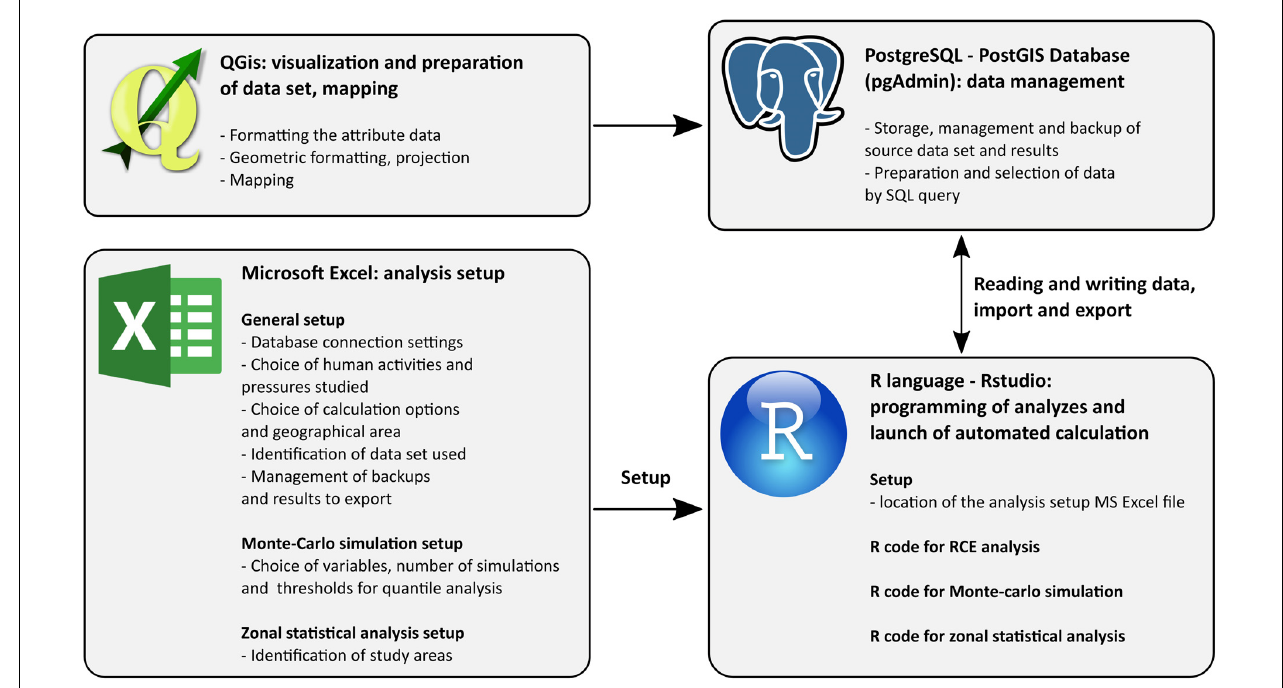
FIGURE 1 | Software used for the